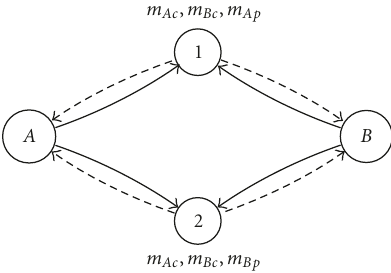
Figure 2: Decoded messages at the two-relays in the DF strategy.